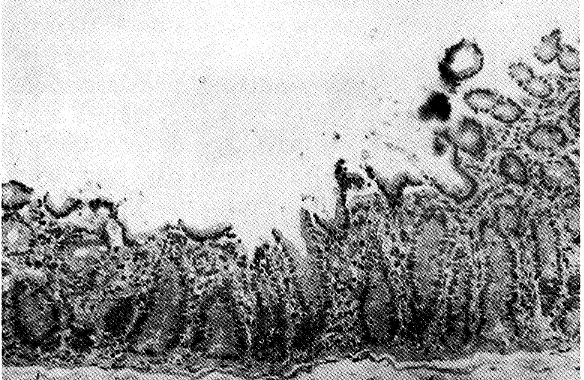
FIG. 2. Inflammation of the mid-colon from a rat stressed for 4 h. Note denuded epithelium, inflammatory cells and hemorrhage in the lamina propria. (Magnification x 200, H & E stain)